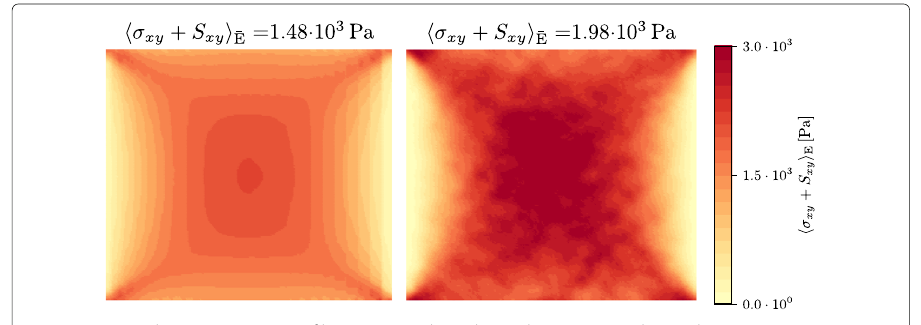
Fig. 3 Averaged system response of beam networks with regular ( β = 0) and irregular ( β = 5) microstructures, simple shear loading by rigid displacement of the top and bottom surface by ± 0.025 H